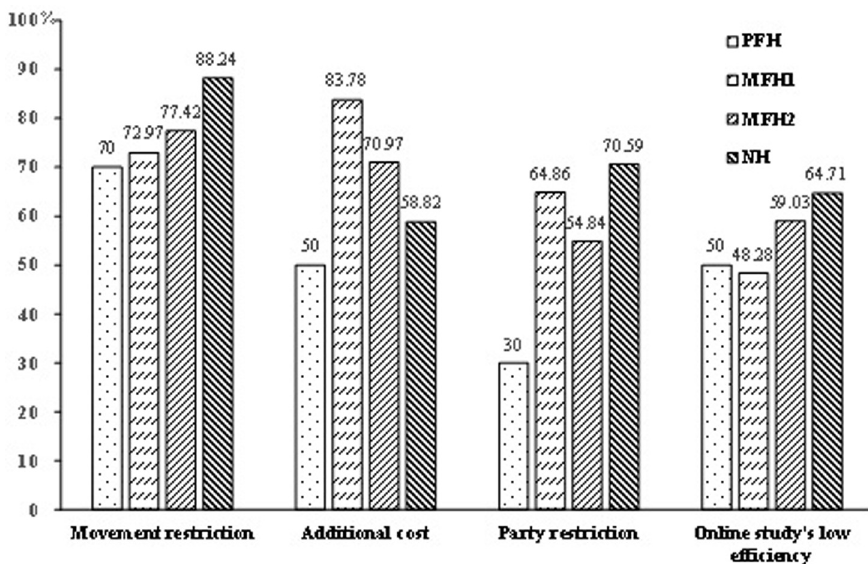
Fig 2. Perception of COVID-19 impacts on daily life for different rural